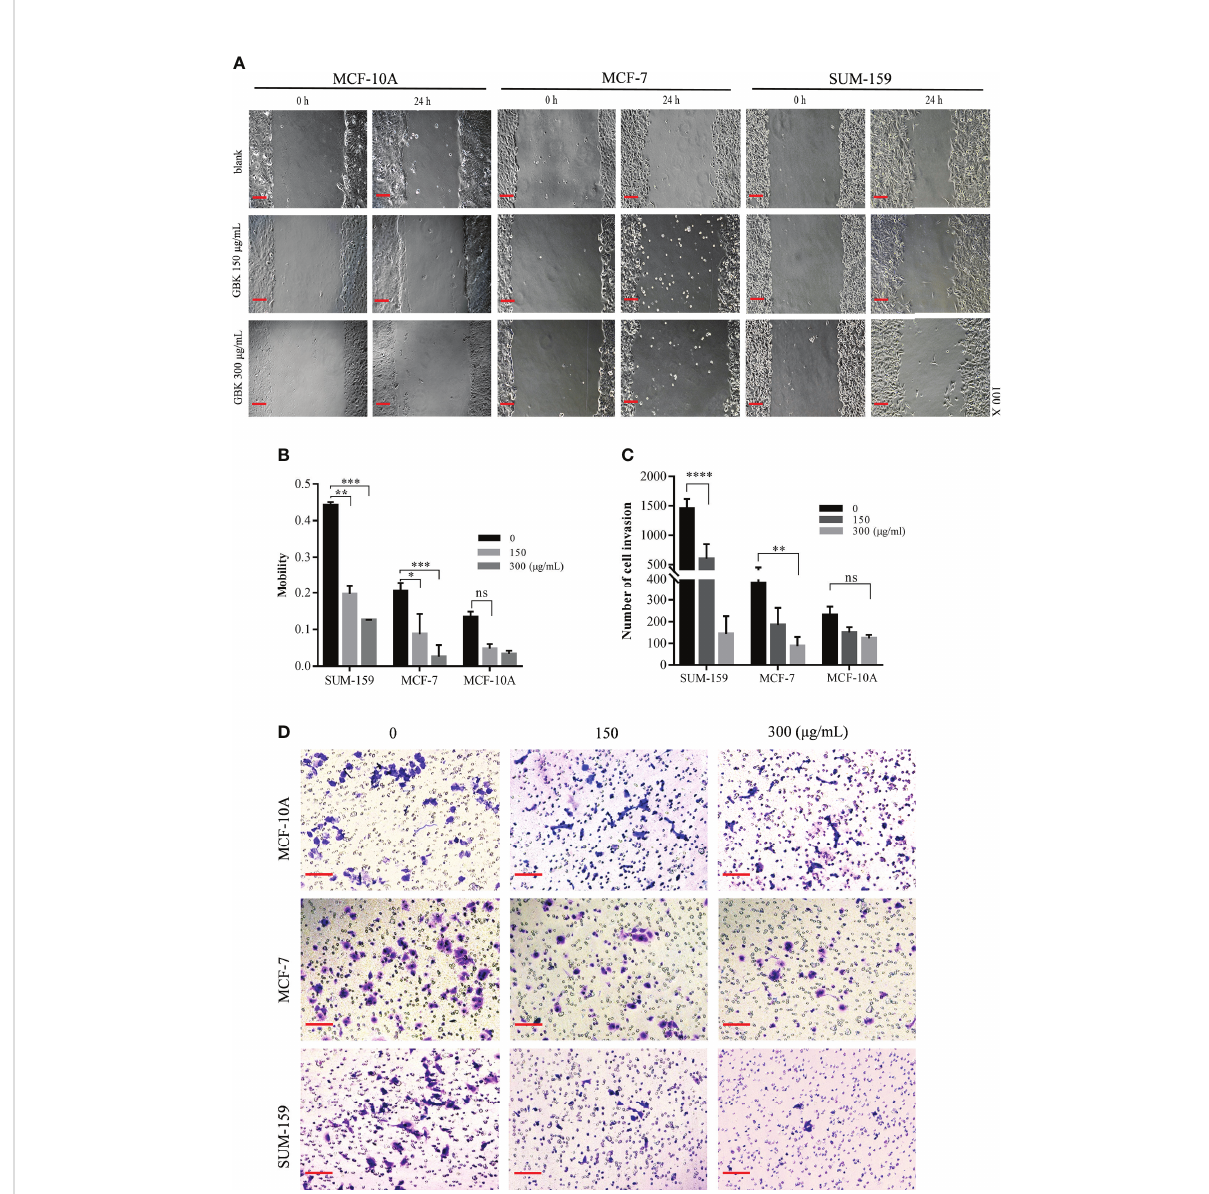
FIGURE 1 GBK impairs the migration and invasion ability of breast cancer cells (A) MCF-10A, MCF-7, and SUM-159 cells were scratched and treated with different concentrations of GBK. Cell images were captured after 24 hours (original magni fi cation, ×10, scale bar (black) as shown). (B) The cell mobility was analyzed using Image J software. Cell motility = (t 0 h scratch width - t 24 h scratch width)/t 0 h scratch width. (C) Cell invasion after GBK treatment was investigated using the Matrigel invasion assay. Cell numbers were calculated by imaging fi ve different fi elds, and the quanti fi cation of results is showed. (D) Photos of representative fi elds of cell invasion are shown. Data are presented as mean ± s.e.m. of at least three independent experiments. Student ’ s t test, *p < 0.05, **p < 0.01, ***p < 0.001, ****p < 0.0001. ns, no signi fi cance. Scale bar represents 20 m